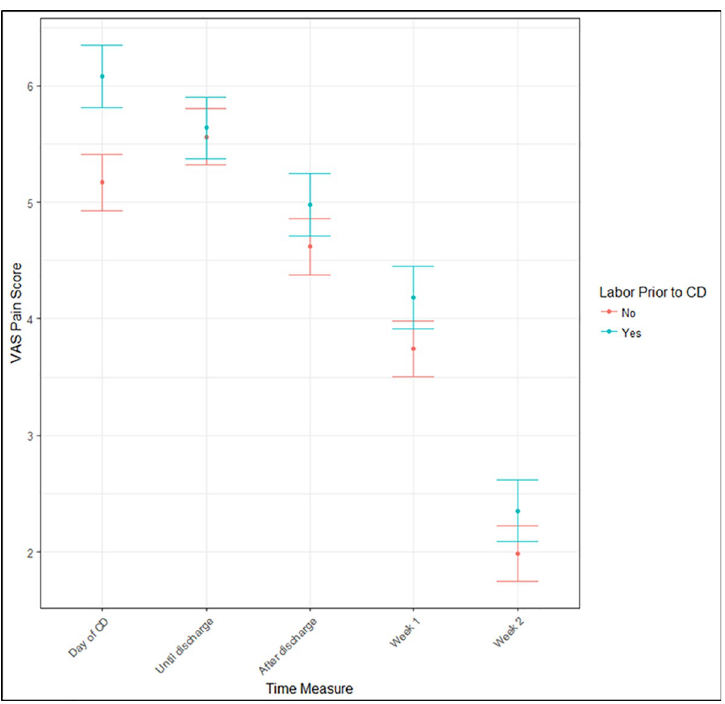
Fig 2. Median pain scores over time of women who labored prior to cesarean delivery versus those who did not.